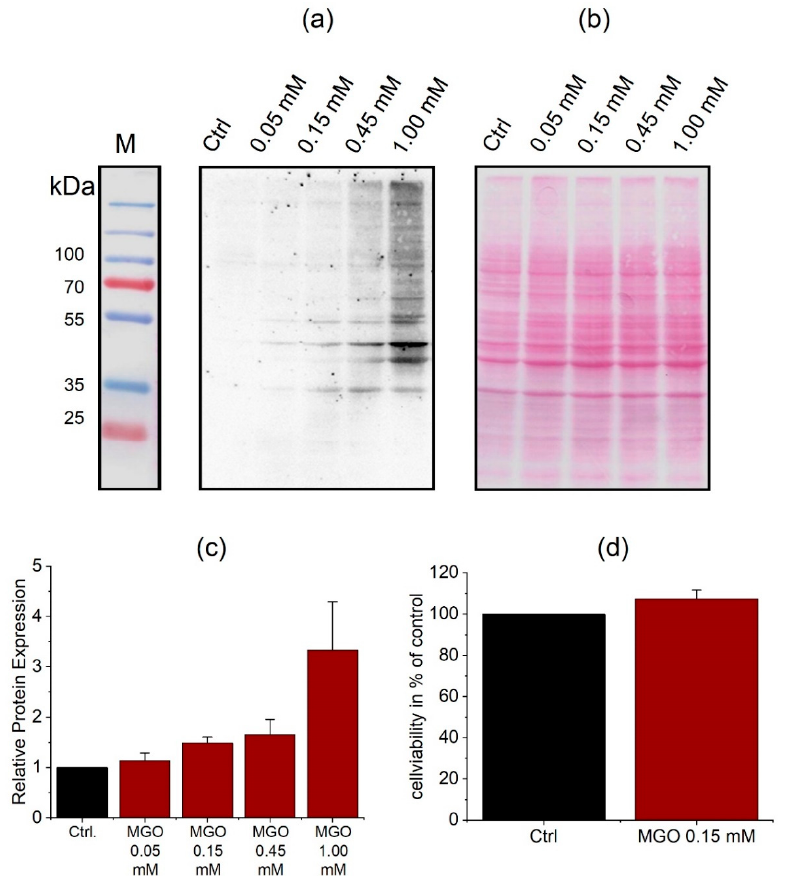
Figure 2. THBMECs were incubated with MGO at di ff erent concentrations for 1 h in normal medium. Total protein was isolated and separated using SDS-PAGE. Glycation of proteins was detected by immuno-blotting using anti-AGE-antibody (CML-26) ( a ). Ponceau S staining served as loading control ( b ). The bar graph shows the mean + SEM of relative protein glycation detected by immunoblotting, untreated cells serve as control ( c ), ( n = 5). Cell viability in THBMECs upon treatment with MGO ( d ). Cells were treated with 0.15 mM MGO for 1 h. Afterwards, MTT assays were performed. The graph shows the mean + SEM of the absorbance of formazan crystals at a wavelength of 570 nm, untreated cells served as control, ( n =